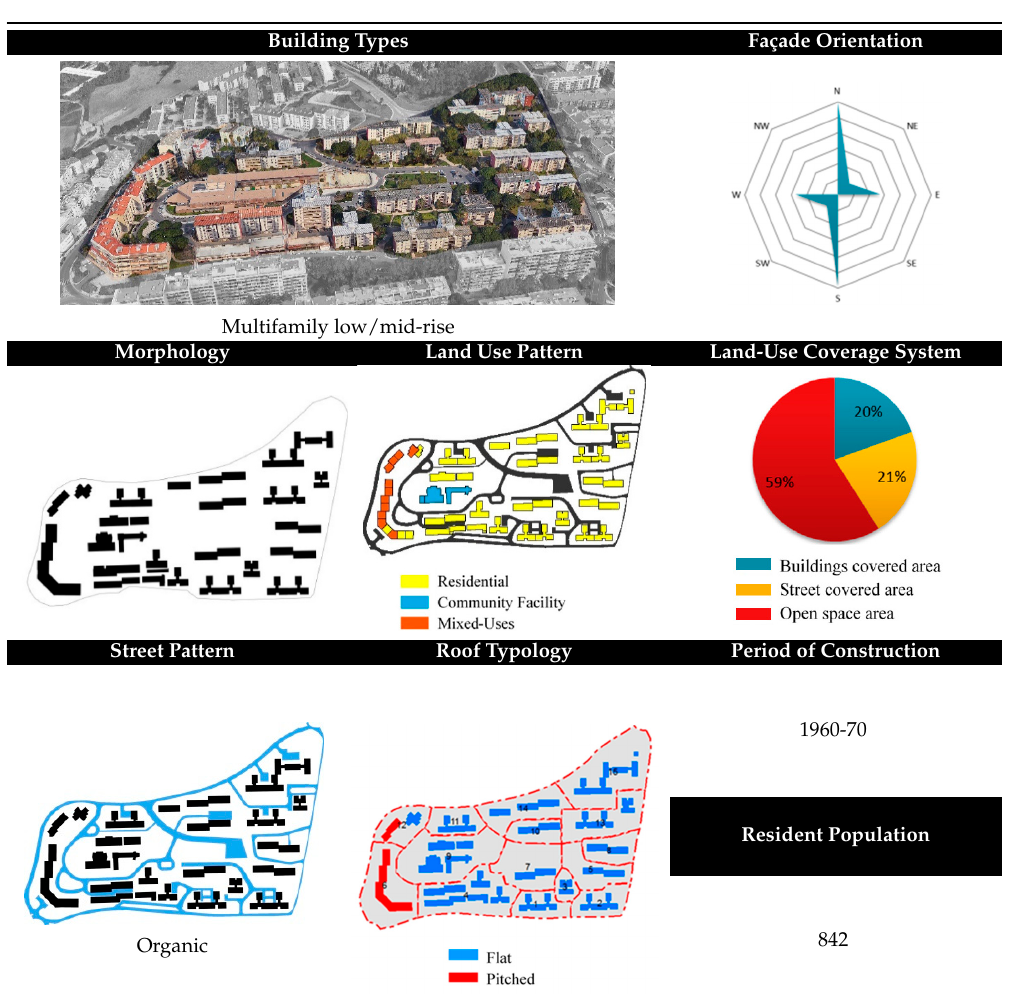
Table 3. Urban unit selected for validation. (Reproduced with permission of Elsevier).